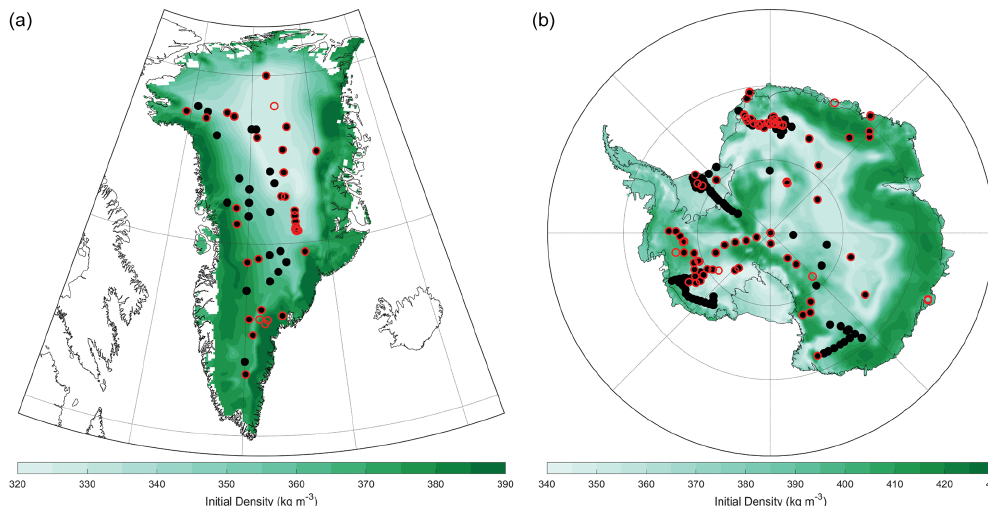
Figure 1. Modeled time-invariant initial density for the (a) Greenland and (b) Antarctic ice sheets. These results are based on MERRA-2 mean surface climate conditions. The solid black circles indicate locations that were used to train and test the initial density model as well as used in stage 1 calibration (Sect. 2.1.5), and the red open circles indicate sites used in stage 2 calibration. Note the differences in color scale for Greenland and